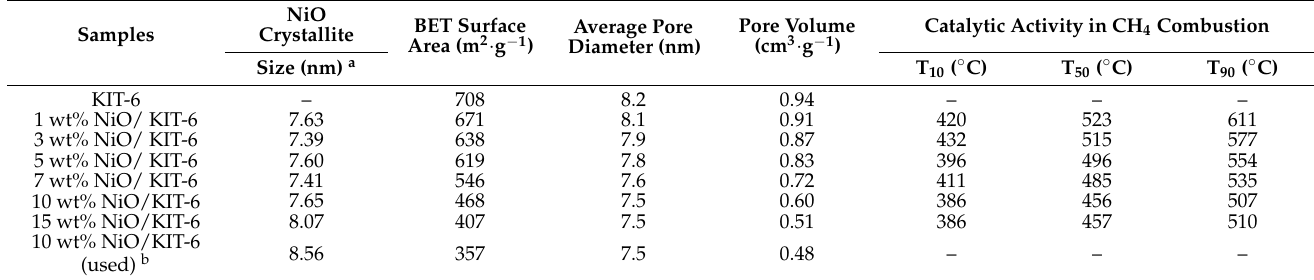
Table 1. Textural properties and catalytic activities of KIT-6 and KIT-6 support NiO samples.